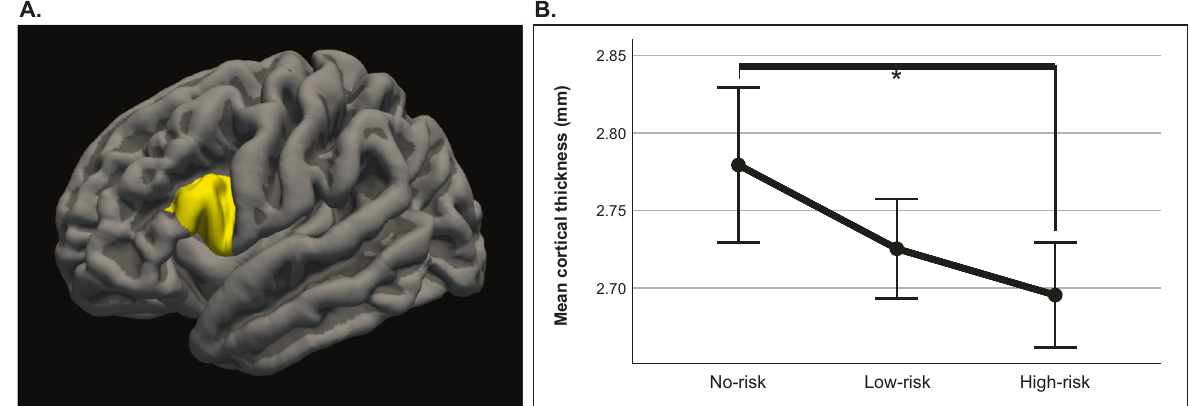
Fig. 1 ROI-based analysis of cortical thickness by individuals at increased risk for development of bipolar disorder. A Left inferior frontal gyrus — pars opercularis as de fi ned by the Desikan − Killiany atlas. B Mean thickness of the left pars opercularis. The post hoc tests revealed a signi fi cantly thinner cortex of the left pars opercularis between no-risk and high-risk groups. The low-risk group tends to have lower thickness than the no-risk group, while having a greater thickness than the high-risk group. However, these differences were not signi fi cant. * denotes statistical signi fi cance at p = 0.012 (FDR-corrected). Error bars represent the 95% con fi dence